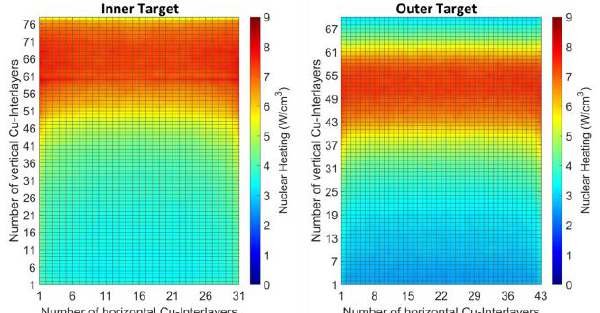
Figure 14. Nuclear heating (W/cm 3 ) distribution on Cu/CuCrZr components of the inner ( left ) and outer ( right ) target, with HCPB blanket.